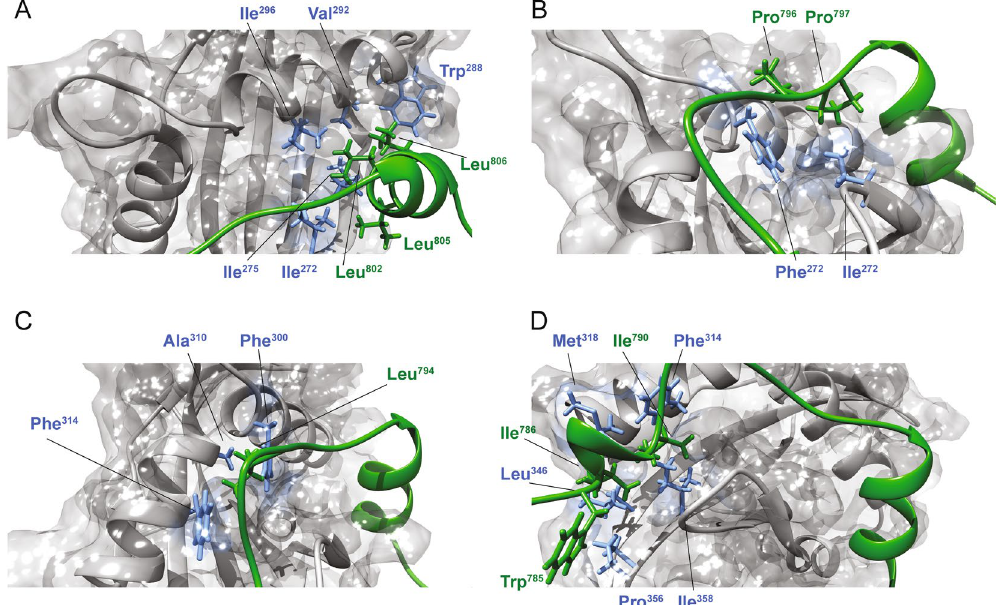
Figure 7. Structural details of the NCoA1 257–385 /STAT6 783–814 interface as reported by the NMR structure (PDB ID: 5NWM). ( A ) STAT6 Leu 802 , Leu 805 and Leu 806 fit into the binding groove of the NCoA1 PAS-B domain. ( B ) STAT6 Pro 796 and Pro 797 interact with residues Ile 272 , Ile 296 , Tyr 297 and Phe 300 located in the C-terminal part of helix α 3 of the NCoA1 PAS-B domain. ( C ) STAT6 Leu 794 is embedded in a shallow hydrophobic depression constituted by the residues Phe 314 , Phe 300 and Ala 310 of the NCoA1 PAS-B domain. Ile 790 is inside a less deep hydrophobic pocket formed by Phe 314 , Met 318 and Ile 358 . ( D ) STAT6 Ile 786 interacts with Met 318 , Leu 346 , Pro 356 and Ile 358 of the NCoA1 PAS-B